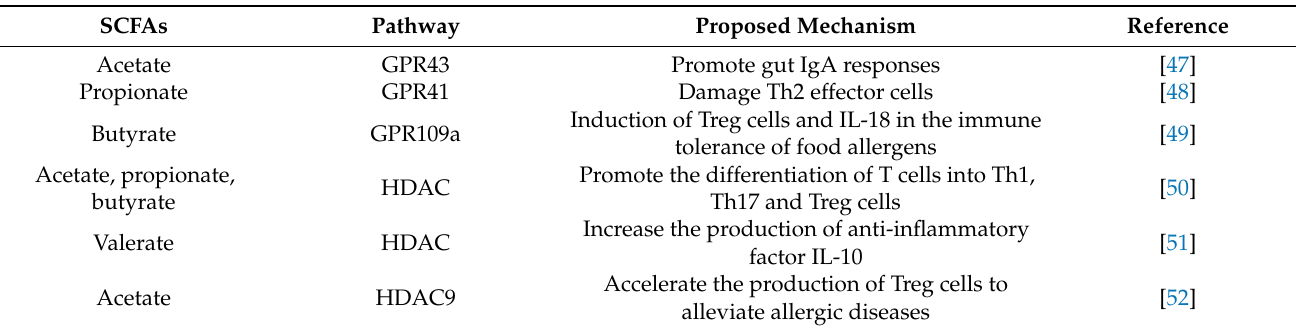
Table 2. Summary of proposed mechanistic actions of the effect that the gut microbial metabolites SCFAs on alleviating the food allergy.